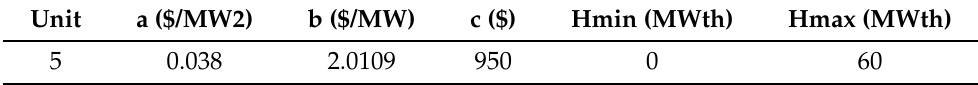
Table A6. Heat energy generator unit data for Case Study 2.